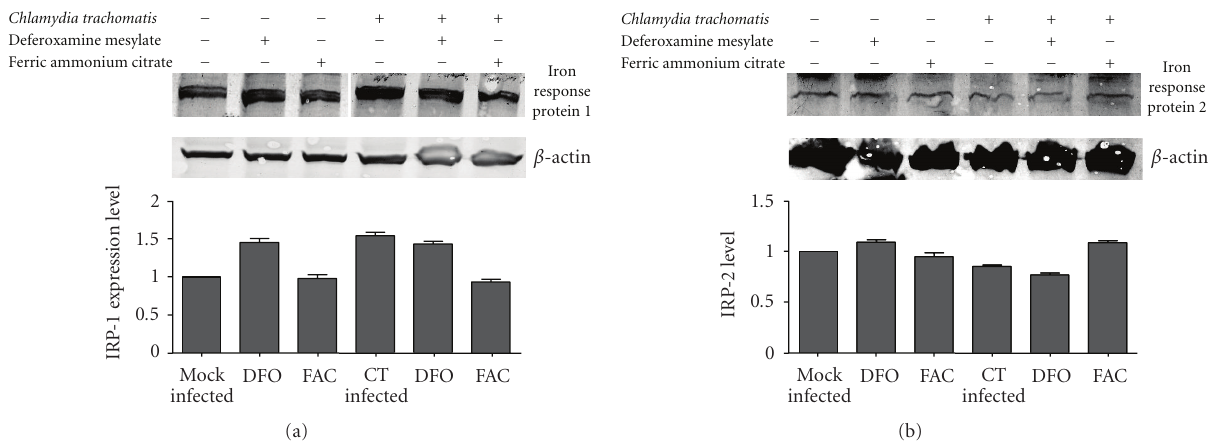
Figure 2: E ff ect of CT infection on IRP-1 expression in HeLa cells: 40 μ g cell lysates were electrophoresed on 8% SDS-PAGE gels, followed by Western blotting using anti-IRP-1 and anti-IRP-2 antibodies, with beta-actin as control. (a) CT-infected HeLa cells showing higher expression of IRP-1, which declined after addition of DFX. (b) Decline in the level of IRP-2 expression was observed in CT-infected HeLa cells, and there was further decline consequent to addition of DFX. No significant change was observed in FAC-treated control and infected cells. Bars represent standard error. ∗ P < . 05 and ∗∗∗ P < .